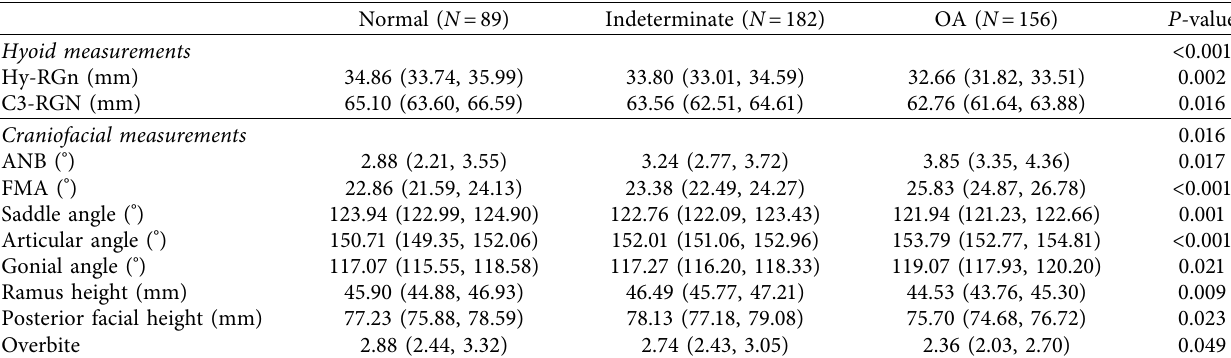
Table 4: Differences in hyoid and craniofacial measurements among the three groups after adjusting age and sex a